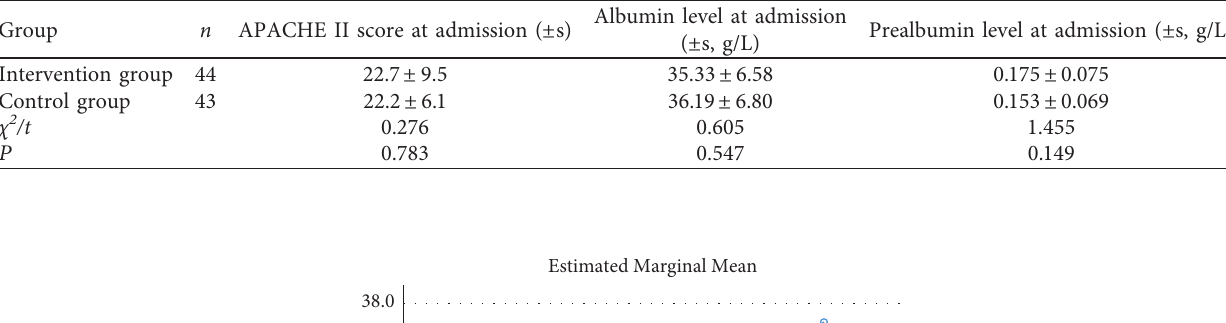
Table 2: APACHE II score at admission, albumin level at admission, and prealbumin level at admission.